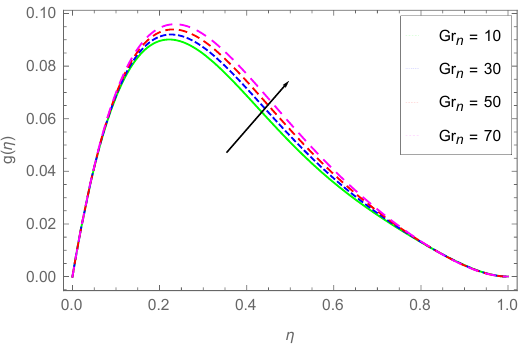
Figure 8. g ( η ) dependence on Gr .